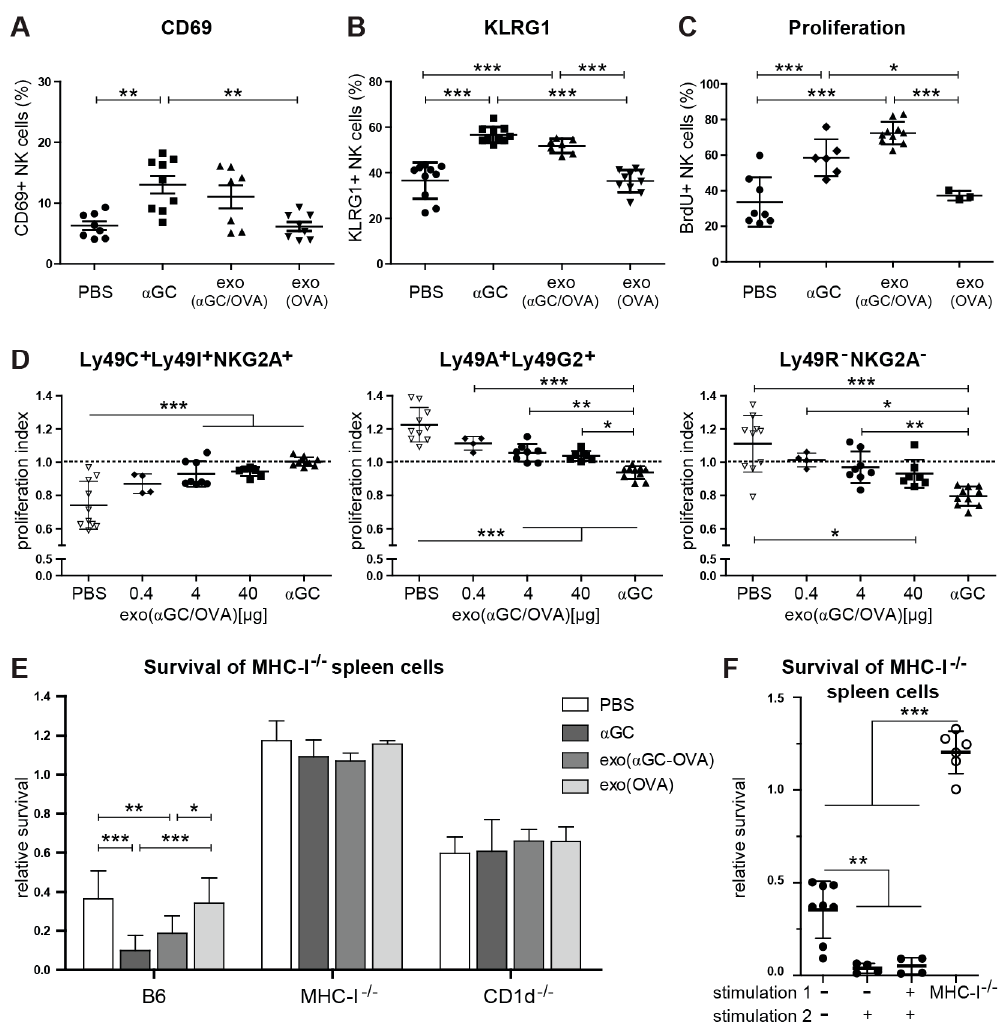
Figure 7. Exosomal α GC has comparable effects on NK cell activation, proliferation and missing self-function. C57Bl/6 mice were injected i.v., with PBS, 40 µg Exo( α GC-OVA) or soluble α GC (equivalent to the amount on 40 µg Exo( α GC-OVA) [47]. ( A ) Activation by CD69 and ( B ) KLRG1 expression was measured by flow cytometry on d7. ( C , D ) Mice were treated with PBS, 0.4, 4 or 40 µg exo( α GC-OVA) or with 200 ng soluble α GC and fed with BrdU in drinking water for 7 days. ( C ) Proliferation was assessed by measuring BrdU incorporation at day 7 on total NK cells. ( D ) NK cells were stained for inhibitory receptors (Ly49C/Ly49I/NKG2A/Ly49A/Ly49G 2 ) and the proliferation index was assessed as described in Materials and Methods. The proliferation index of the Ly49C + Ly49I + NKG2A + Ly49A − Ly49G 2 − (educated on self-MHC-I), the Ly49C − Ly49I − NKG2A − Ly49A + Ly49G 2+ (not educated on self-MHC-I) and the Ly49C − Ly49I − NKG2A − Ly49A − Ly49G 2 − (not educated on self-MHC-I) NK cell subsets are shown. ( E , F ) In vivo missing self-responses were measured by target cell elimination assay. ( E ) B6, MHC-I − / − and CD1d − / − mice were treated with 200 ng soluble α GC, 40 µg Exo(OVA) or 40 µg Exo( α GC-OVA) and challenged at day 7 with a mix of CFSE-labeled B6 (control) and β 2 m − / − spleen cells (target). The ratio of surviving target cells was examined after two additional days. ( f ) B6 mice were treated twice with 40µg exo( α GC-OVA) at an interval of 2 weeks. 3 days after the second treatment (stimulation 2), the rejection capacity was assessed by target cell elimination of CFSE-labeled B6 (control) and β 2 m − / − spleen cells (target). Data are pooled from 3 independent experi- ments ( A – D ) or from 2 independent experiments ( E , F ) with 7–10 mice per group ( A , B ), 3–10 mice per group ( C ), 4–10 mice per group ( D ), 4–12 mice per group ( E ) or 4–8 mice per group ( F ). Error bars denote SD. Significant differences were calculated with one-way ANOVA with Tukey’s correction for multiple testing and are denoted * p < 0.05, ** p < 0.01, *** p < 0.001.